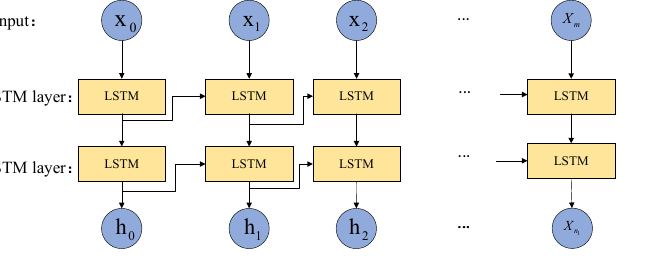
Figure 13. LSTM basic learner structure.